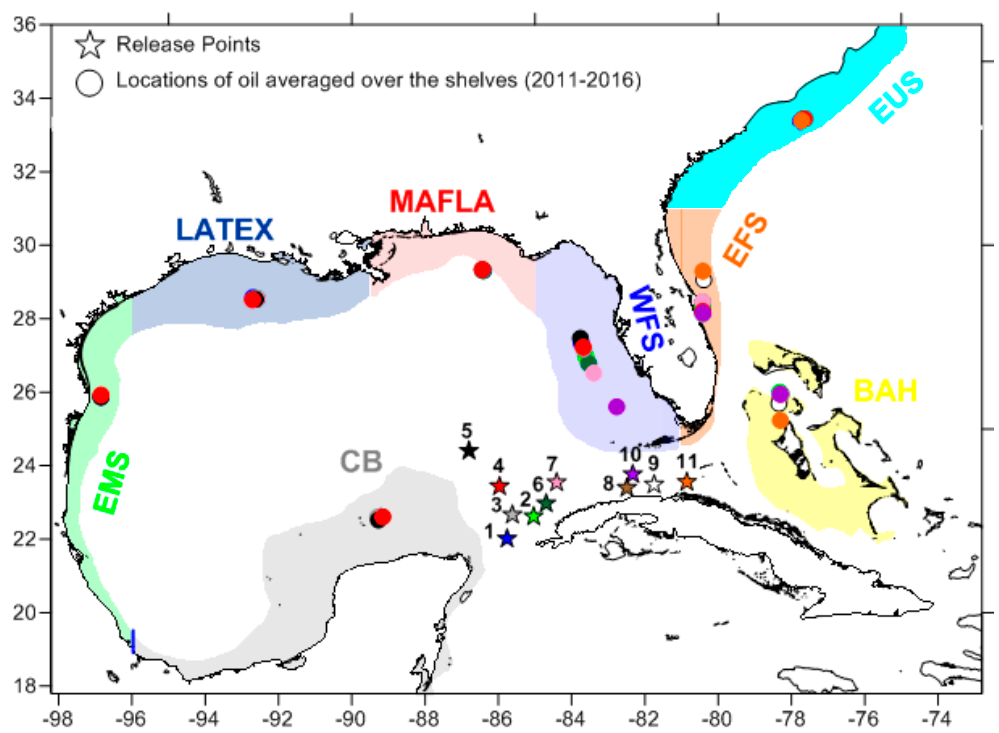
Figure 15. Mean location (2011–2016) of all oil elements that passed over each shelf region derived by averaging the coordinates of these elements within its shelf area. Only the shelf regions for which the number of oil elements that reached them was larger than 25,000 are plotted. Each release point is indicated by a different color (colors match the release points marked as star symbols; Point 1: Blue, Point 2: Light green, Point 3: Grey, Point 4: Red, Point 5: Black, Point 6: Dark green, Point 7: Purple, Point 8: Brown, Point 9: White, Point 10: Magenta, Point 11: Orange). The continental shelf areas, delimited by the 200 m isobath, are presented (Eastern Mexico Shelf: EMS; Louisiana and Texas Shelf: LATEX; Mississippi, Alabama, and Florida Shelf: MAFLA; Western Florida Shelf: WFS; Campeche Bank: CB; Eastern Florida Shelf: EFS; Eastern US Shelf: EUS; Bahamas Shelf: BAH). Note that certain positions represent overlapping mean locations with more than one release points (see Figure 16 and text for details).